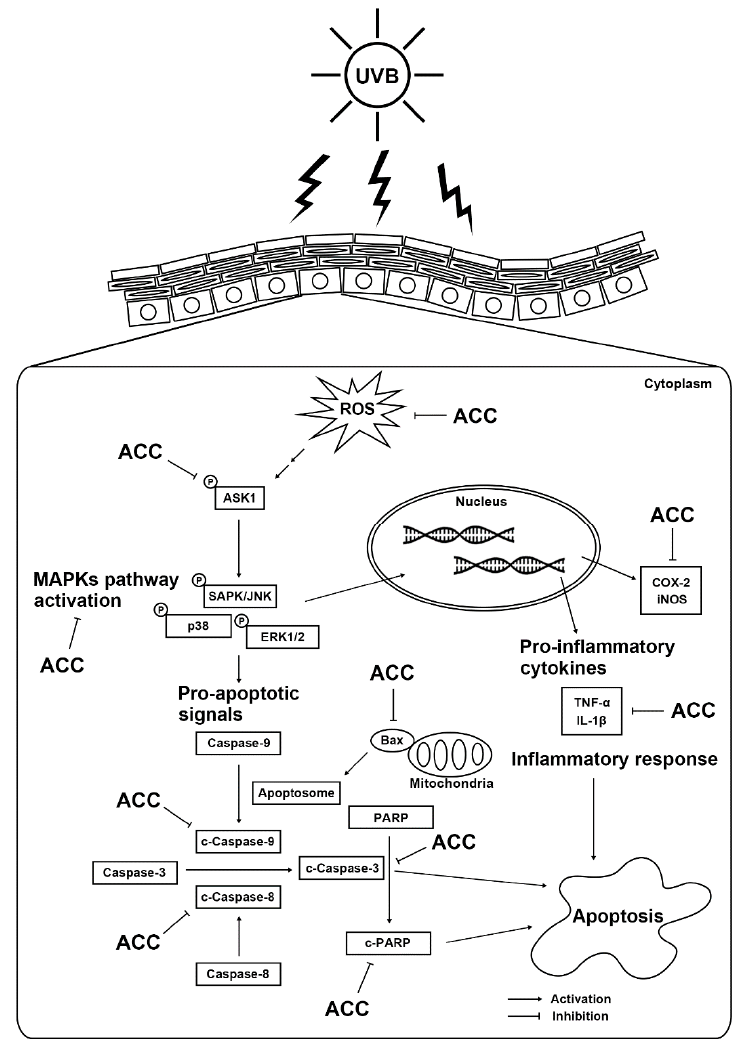
Figure 8. Scheme of the beneficial effects of ACC in UVB-irradiated HaCaT cells.